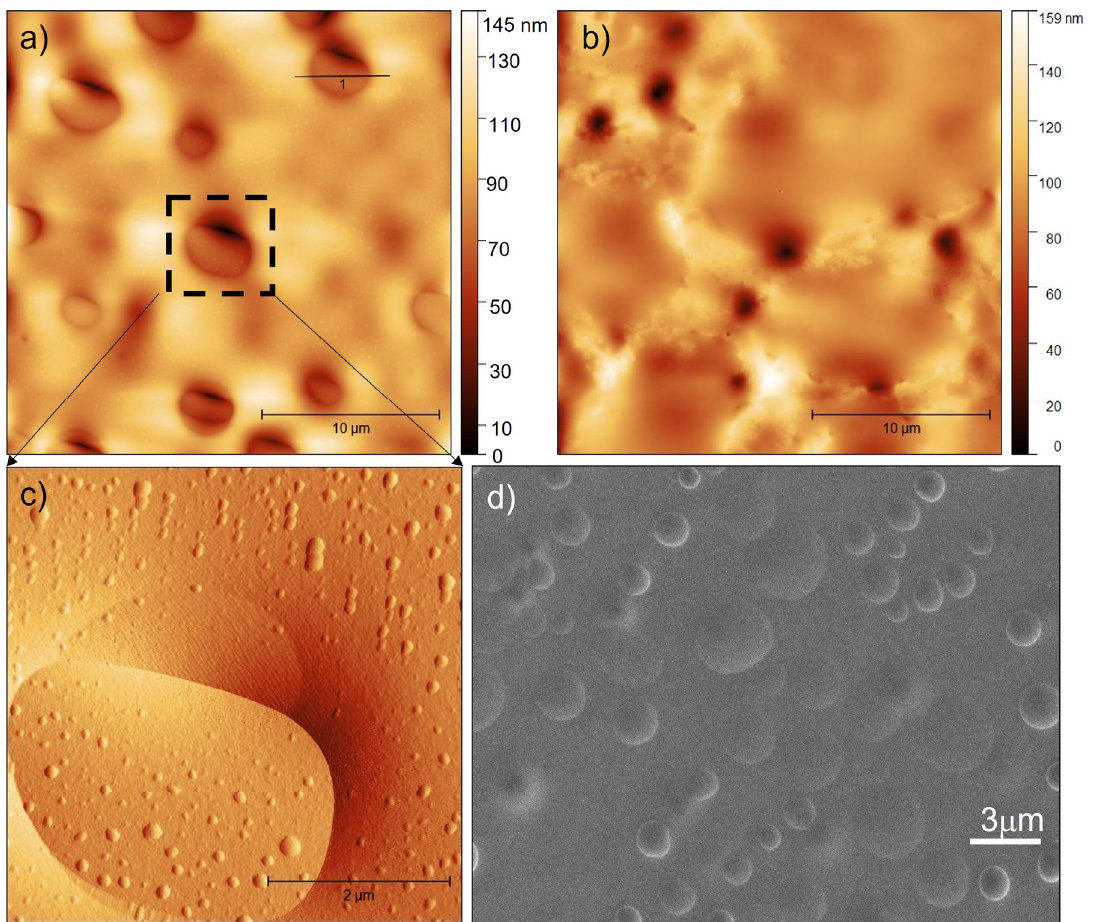
Figure 3. ( a ) Topography AFM image achieved in tapping mode of a spin-coated cellulose film (the dashed-line rectangle identifies the area shown in panel ( c )). ( b ) Topography AFM image achieved in tapping mode of a spray-coated cellulose film. ( c ) High-resolution tapping amplitude AFM image obtained by scanning the area indicated in panel ( a ). ( d ) SEM image of a spin-coated cellulose film. By focusing on a small area, it is possible to identify smaller depressions with a diameter of ~100 nm (Figure 3c).